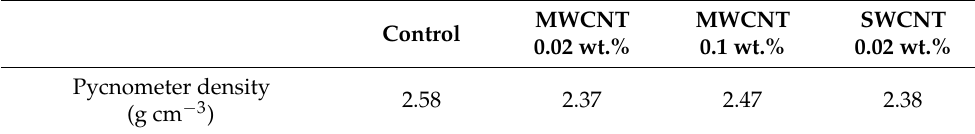
Table 3. Density results of control sample and CNTs reinforced cement